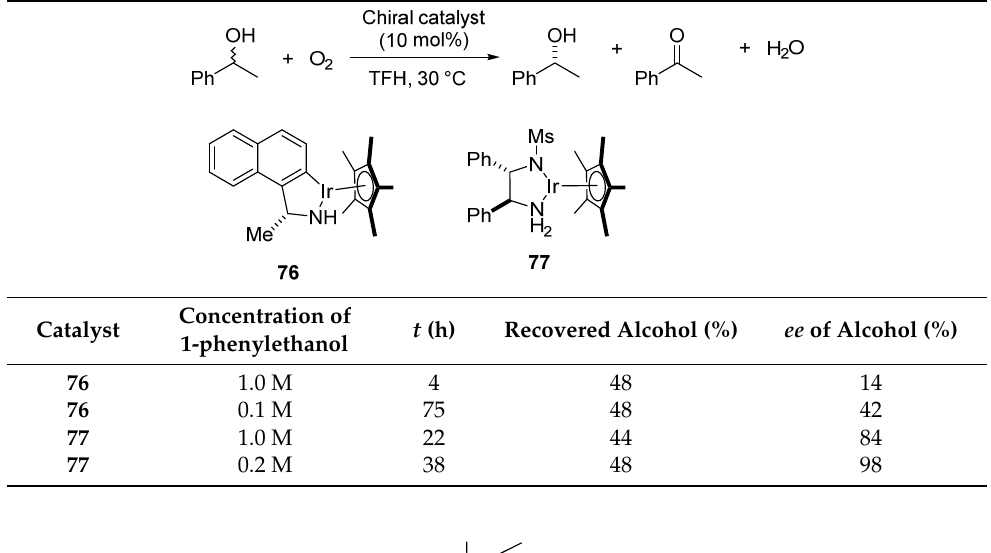
Table 2. Aerobic oxidative kinetic resolution of secondary alcohols.